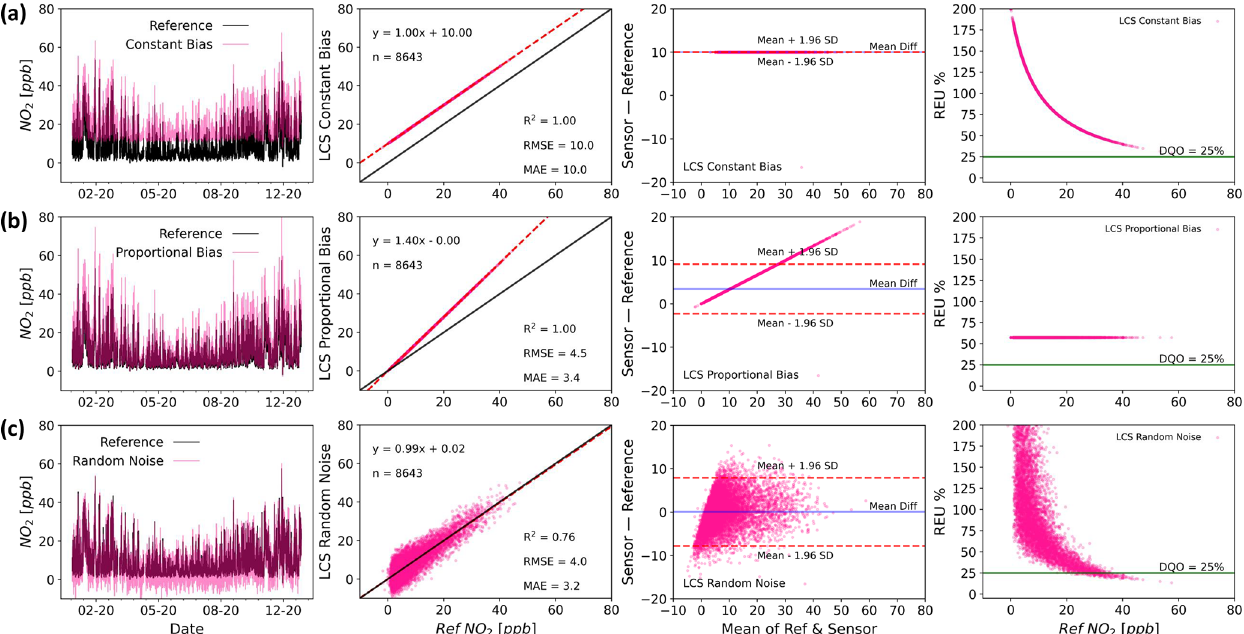
Figure 1. Time series (first column), regression (second column), Bland–Altman (third column) and REU (fourth column; Data Quality Objective (DQO) for NO 2 = 25%) plots for arbitrary examples of pure constant bias (slope = 1, intercept = 1, SD ε = 0; a ), pure proportional